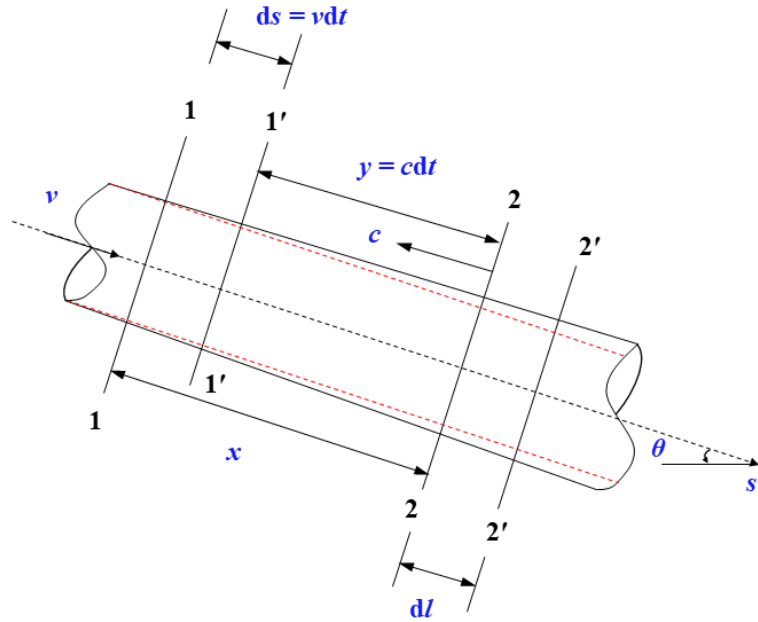
Figure 2. Schematic diagram of water hammer wave propagation.